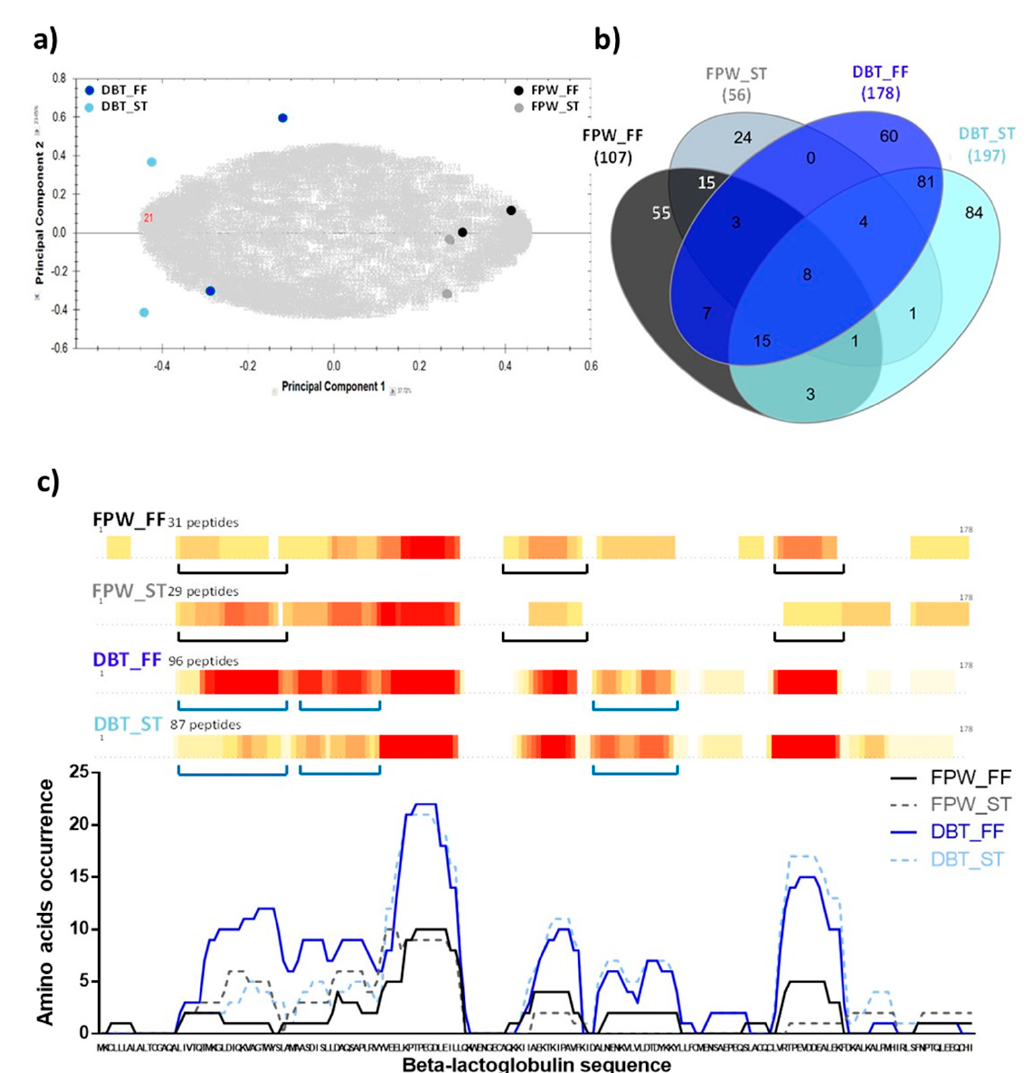
Figure 7. Overall number of common and unique peptides identified in the 4 h whey protein hydrolysates generated using FlavorPro Whey (FPW) and Debitrase (DBT) under pH- and non pH-controlled conditions (ST and FF, respectively). ( a ) Principal component analysis based on comparison of mass spectrometry detected peptides in the WPHs, ( b ) Venn diagram representing the overall number of identified peptides in the WPHs with the common peptide identified in several samples represented by the overlapping area in the diagram and ( c ) Heat map showing amino acid occurrence in the identified peptides in the primary sequence of β -lactoglobulin where the red colour represents high number of identifications, yellow represents low number of identifications and white represents unidentified amino acids. Underlined regions highlight peptide pattern differences between ST and FF conditions for FPW (in black) or DBT (in blue) hydrolysis.